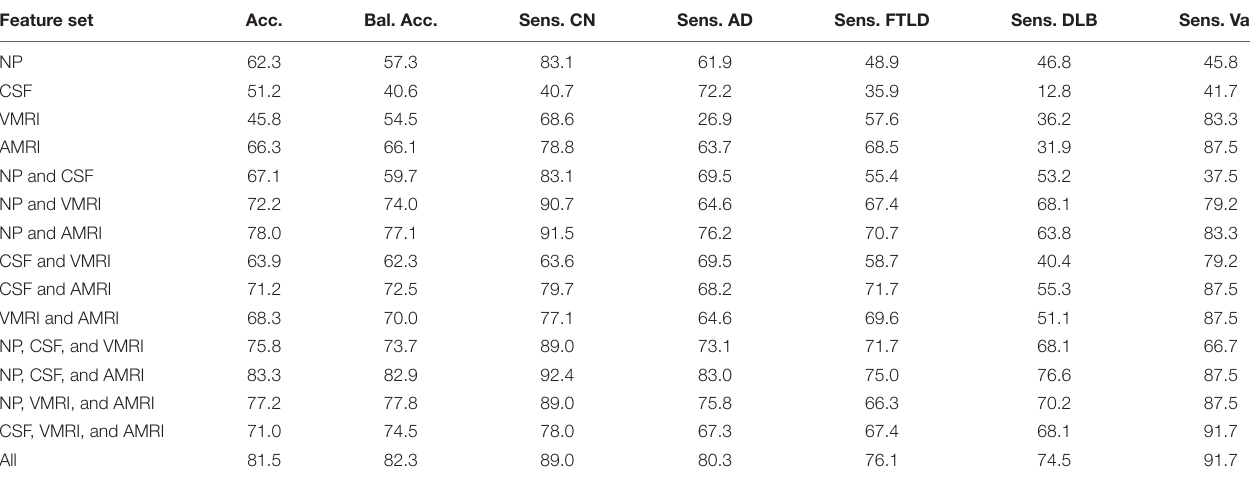
TABLE 3 | Accuracy, balanced accuracy, and sensitivities [%] for all diagnostic groups, using different subsets of the data sources. Feature